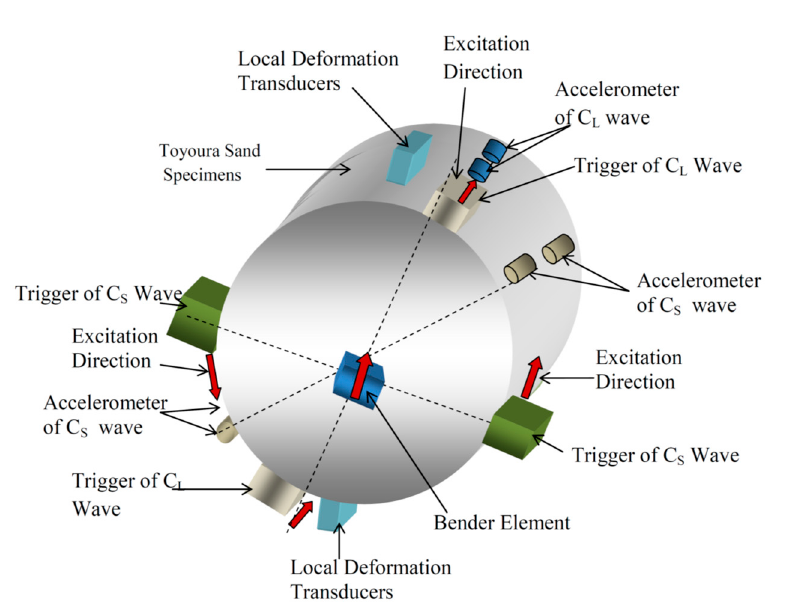
Figure 13. Specimen shape and the position of bender element, trigger of (C L and C S ) waves, and accelerometer of ( C L and C S ) waves.